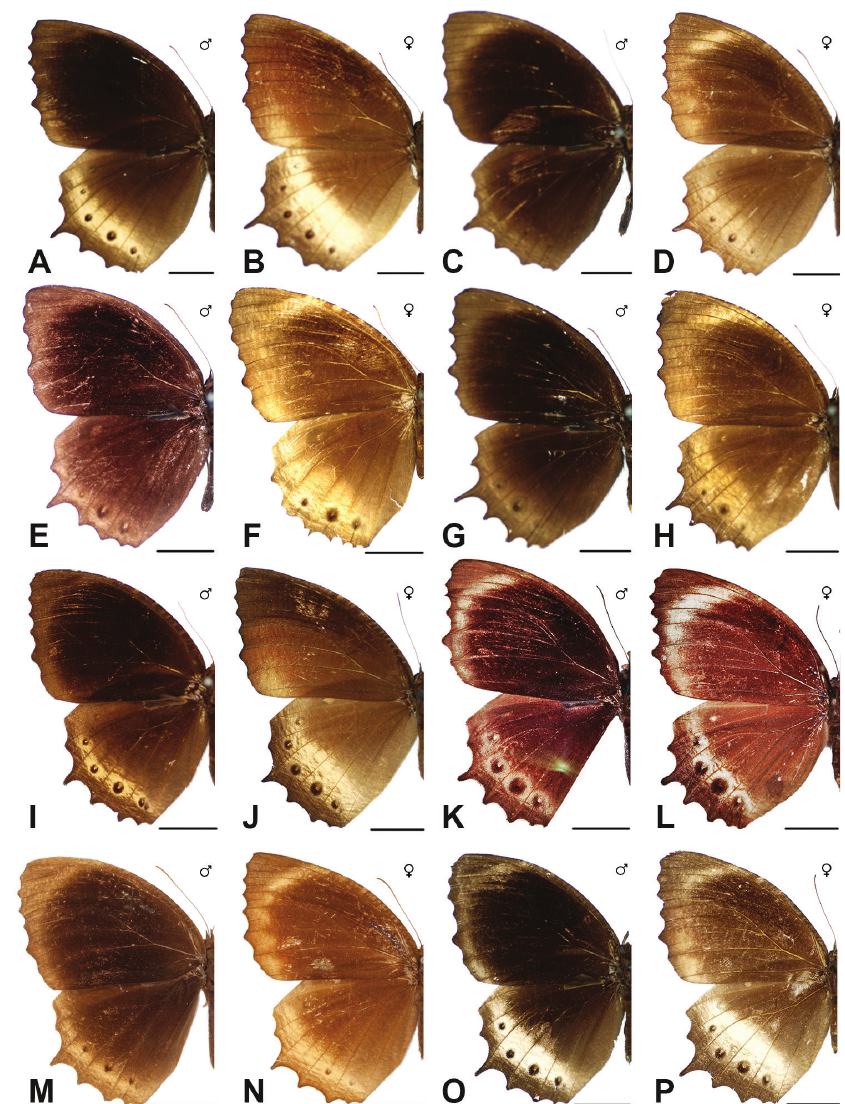
Figure 10. A panthera panthera ♂ D NHM Peninsular Malaysia B panthera panthera ♀ D NHM Peninsular Malaysia C panthera dusara ♂ D NHM Indonesia: Java D panthera dusara ♀ D NHM In- donesia: Java E panthera mimus ♂ D NHM India: Nicobar Islands F panthera mimus ♀ D NHM India: Nicobar Islands G panthera dolorosa ♂ D NHM Indonesia: North Sumatra, Nias H panthera dolorosa ♀ D NHM Indonesia: North Sumatra, Nias I panthera lutescens ♂ D NHM North Borneo J panthera lutescens ♀ D NHM East Malaysia: Sarawak K panthera suluana ♂ D SMFD collection locality unknown L panthera suluana ♀ D SMFD Philippines: Tawi-tawi, Mapun Island M panthera tautra ♂ D NHM Indonesia: Sumatra, Bengkalis, Senggoro N panthera tautra ♀ D NHM Indonesia: Sumatra, Bengka- lis, Senggoro O panthera arikata ♂ D NHM Indonesia: Riau Islands, Natuna P panthera arikata ♀ D NHM Indonesia: Riau Islands,